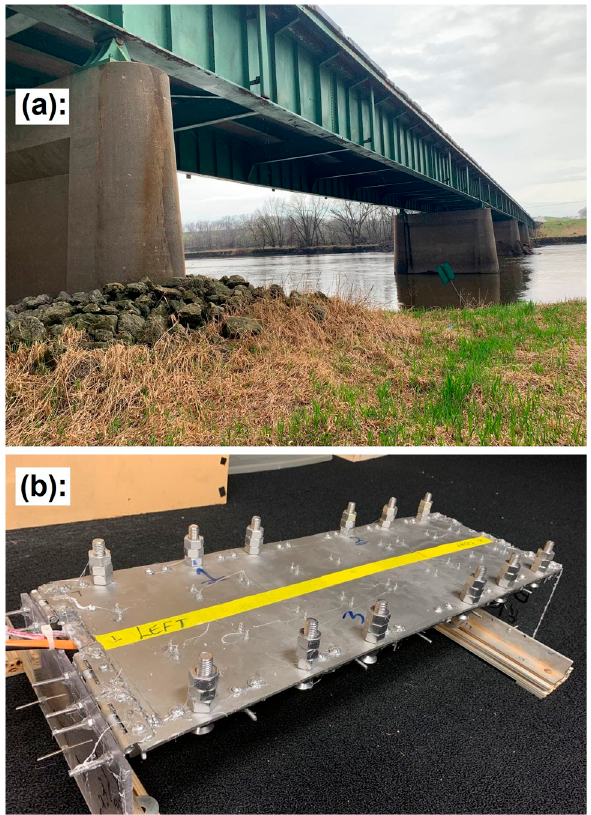
Figure 1. Representative highway bridge (FHWA #33472): ( a ) full-scale model; ( b ) small-scale model.